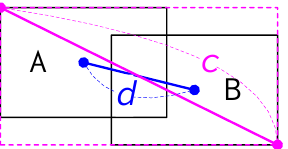
Figure 4. Distance-IoU (DIoU) calculation of two overlapping boxes.